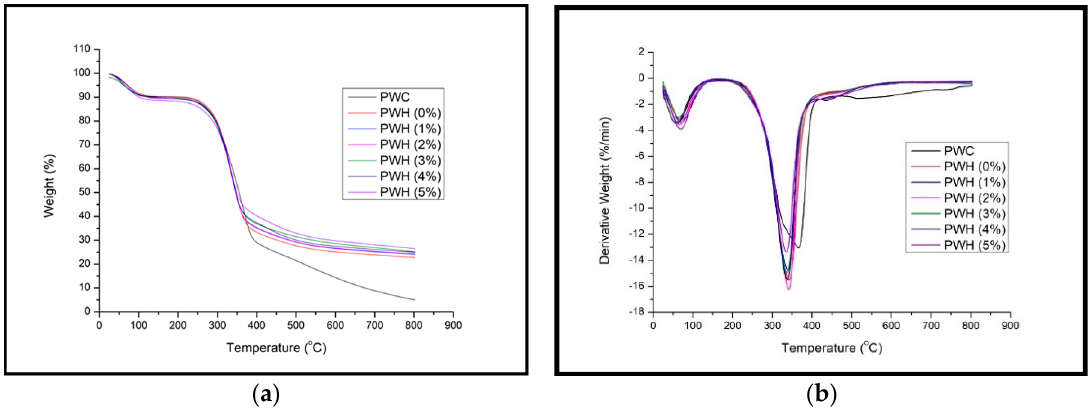
Figure 13. a ) Thermogravimetry (TGA) and b ) Derivative Thermogravimetric (DTG) PWV with different loading of PF filled OPA nanoparticles compared to PWC. di ff erent loading of PF filled OPA nanoparticles compared to PWC.